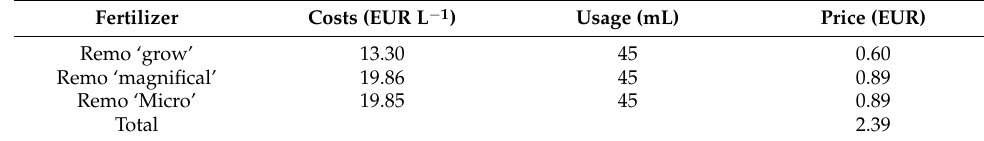
Table 3. SOF inputs: Overview of types, amounts and costs of the fertilizers used in this study.